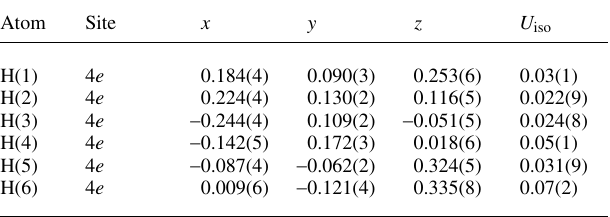
Table 4. Data collection and handling. Table 5. Atomic coordinates and displacement parameters (in Å 2 )